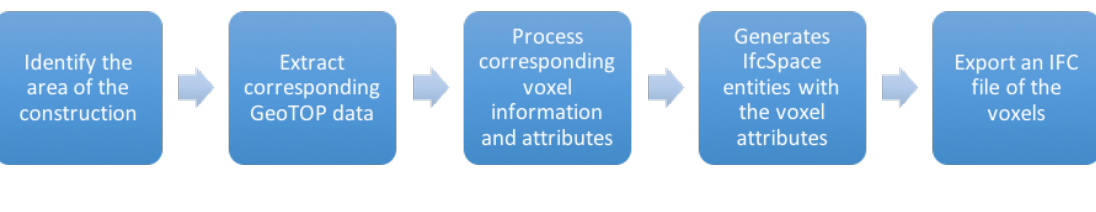
Figure 10. Workflow of this solution.